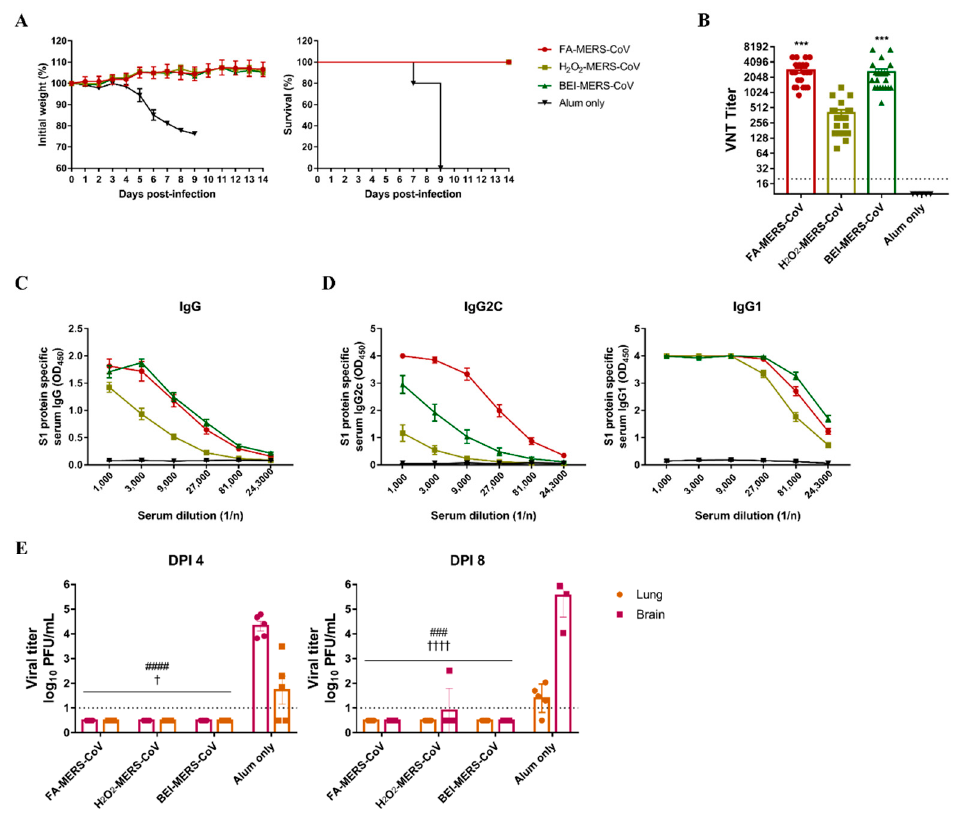
Figure 2. The three inactivated MERS-CoV induced a protective immune response against MERS-CoV infection in the hDPP4-transgenic mouse model. ( A ) Changes in body weight and survival rate were monitored for two weeks after MERS-CoV infection. The survival symbols of H 2 O 2 -MERS-CoV and BEI-MERS-CoV overlapped with FA-MERS-CoV. ( B ) MERS-CoV specific neutralizing antibodies (nAbs) and ( C , D ) S1 protein-specific serum IgG/IgG2c/IgG1 levels were measured for two weeks after the third immunization. ( E ) MERS-CoV titers in lung and brain tissues were observed by plaque assay on dpi 4 and 8 after the MERS virus challenge. Data are represented as the mean ± S.E.M. *** p < 0.001 compared with alum only. ### p < 0.001, #### p < 0.0001 compared with alum only lung. † p < 0.05, †††† p < 0.00001 compared with alum only brain.